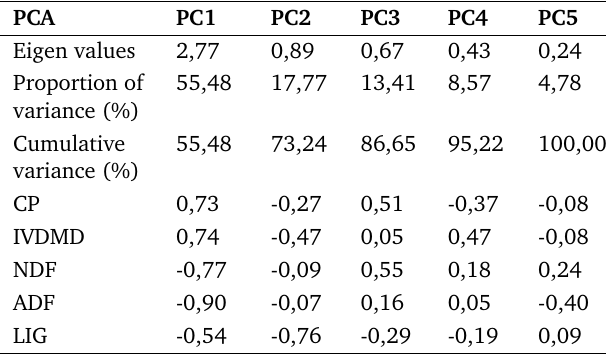
Table 4. Principal component analysis (PCA) of the 80 accessions of Stylosanthes scabra Vogel. CP, Crude Protein;